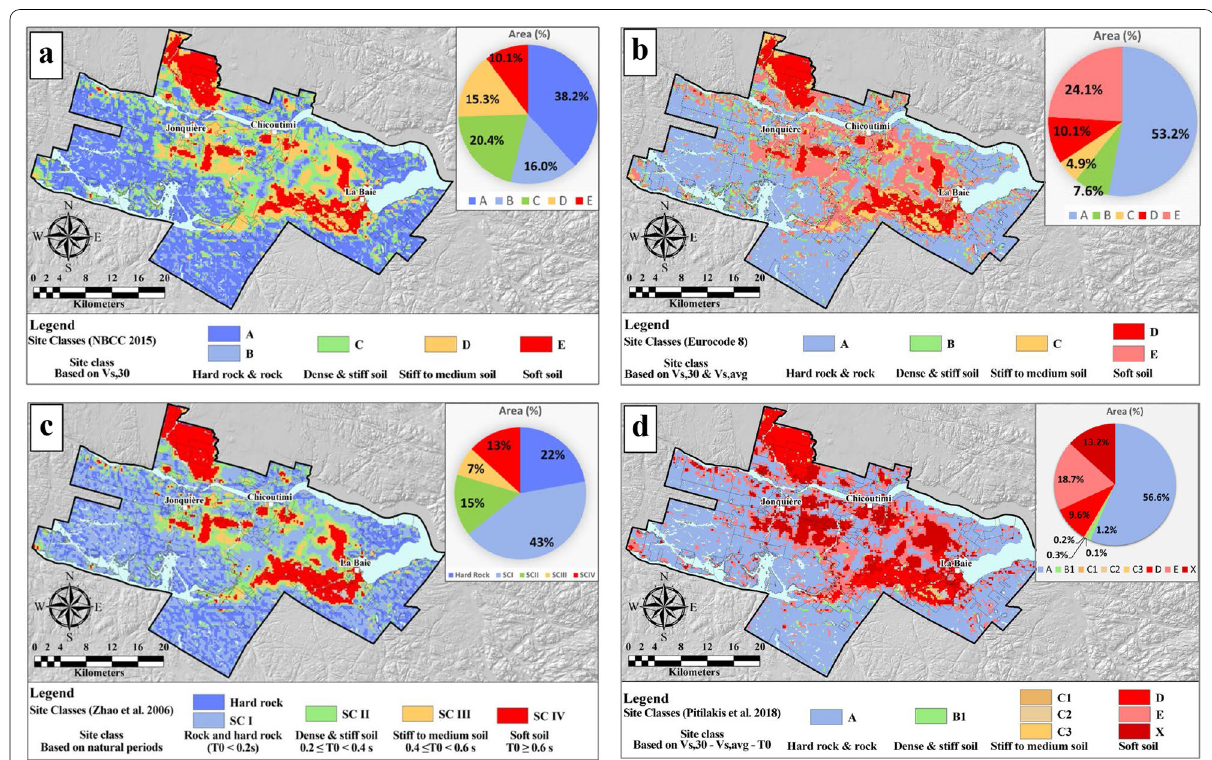
Fig. 4 Spatial distribution of seismic site classes and relative coverage of the study area based on site classification methods: a NBCC, b Eurocode 8, c fundamental periods of soil ( T 0 ) and d hybrid